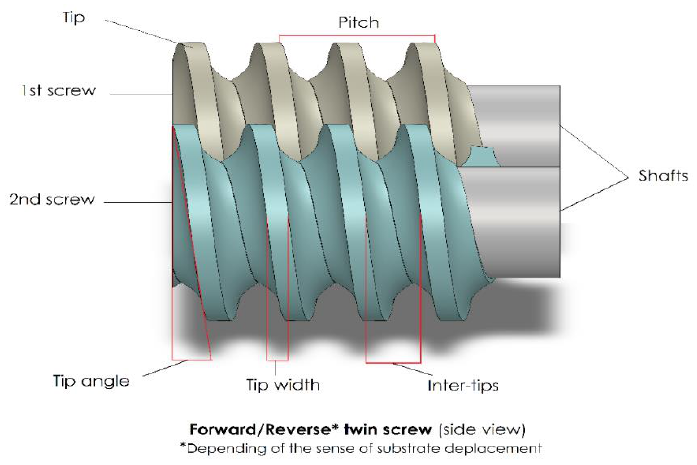
Figure 7. Intermeshing forward/reverse twin-screw elements.